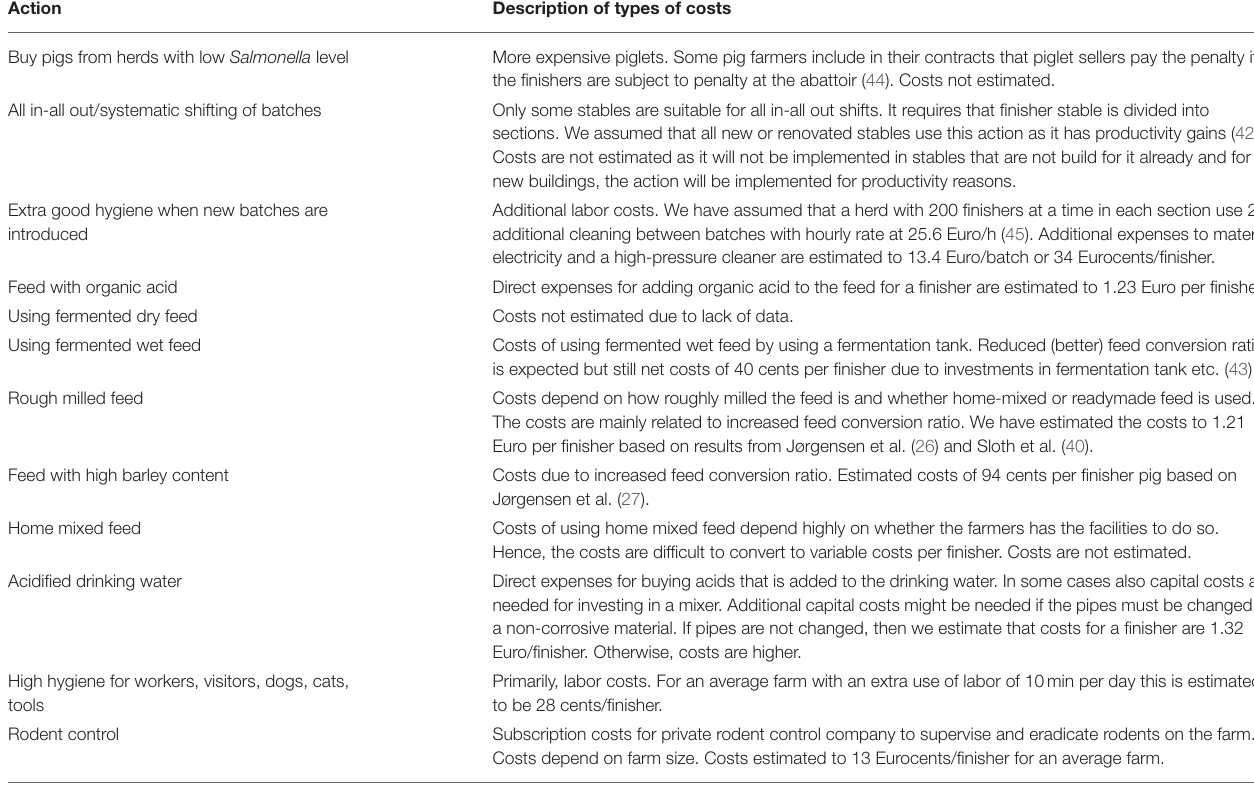
TABLE 3 | Description of the 12 Salmonella actions and the types of costs involved. Action Description of types of